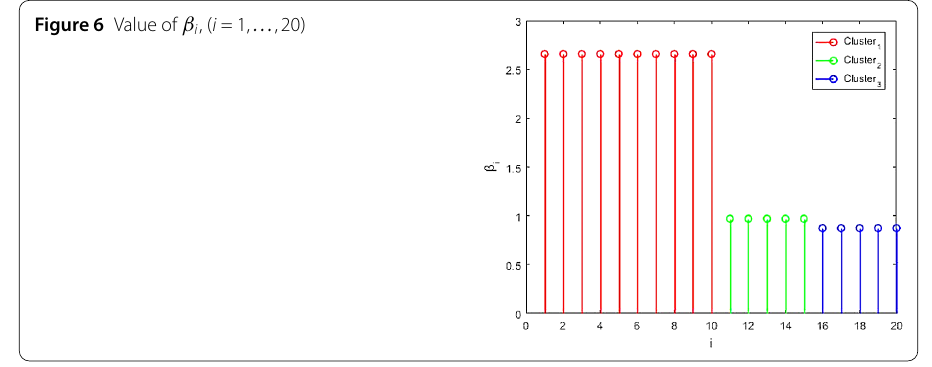
Figure 6 Value of β i , ( i = 1, ... ,20)